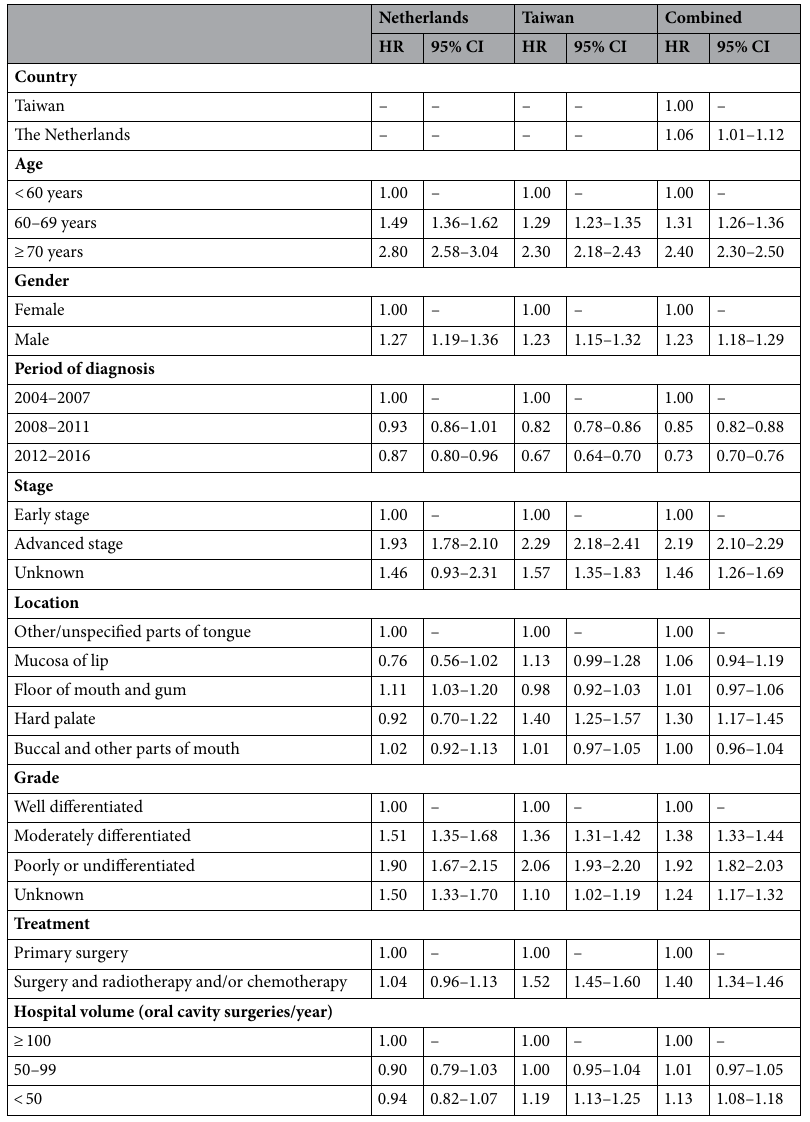
Table 3. Multivariable cox regression analyses. The figures in the Netherlands and Taiwan columns are computed locally, while the Combined column was computed using the privacy-preserving federated